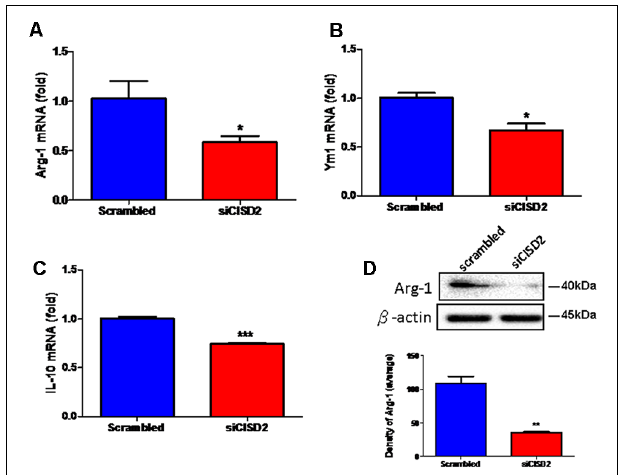
FIGURE 2 | Knockdown of CISD2 expression downregulated (A) Arg-1, (B) YM1, (C) IL-10 mRNA expression, and (D) Arg-1 protein expression in non-stimulated EOC microglial cells. In (A–C) , data indicate means ( ± SEM) of fold decrease of Arg-1, YM1, and IL-10 mRNA in comparison to that in the scrambled control group analyzed by real-time qRT-PCR in siCID2-transfected groups ( n = 3 in each group). * p < 0.05; *** p < 0.001 as compared with scrambled control. In (D) , the upper panel demonstrates the immunoblot results of Arg-1 at 40 kDa, and β -actin serves as an internal control; the lower panel indicates the mean ( ± SEM) of Arg-1/ β -actin band intensity in ratio with the scrambled control ( n = 3). ** p < 0.01 indicates the significant difference compared with scrambled control.